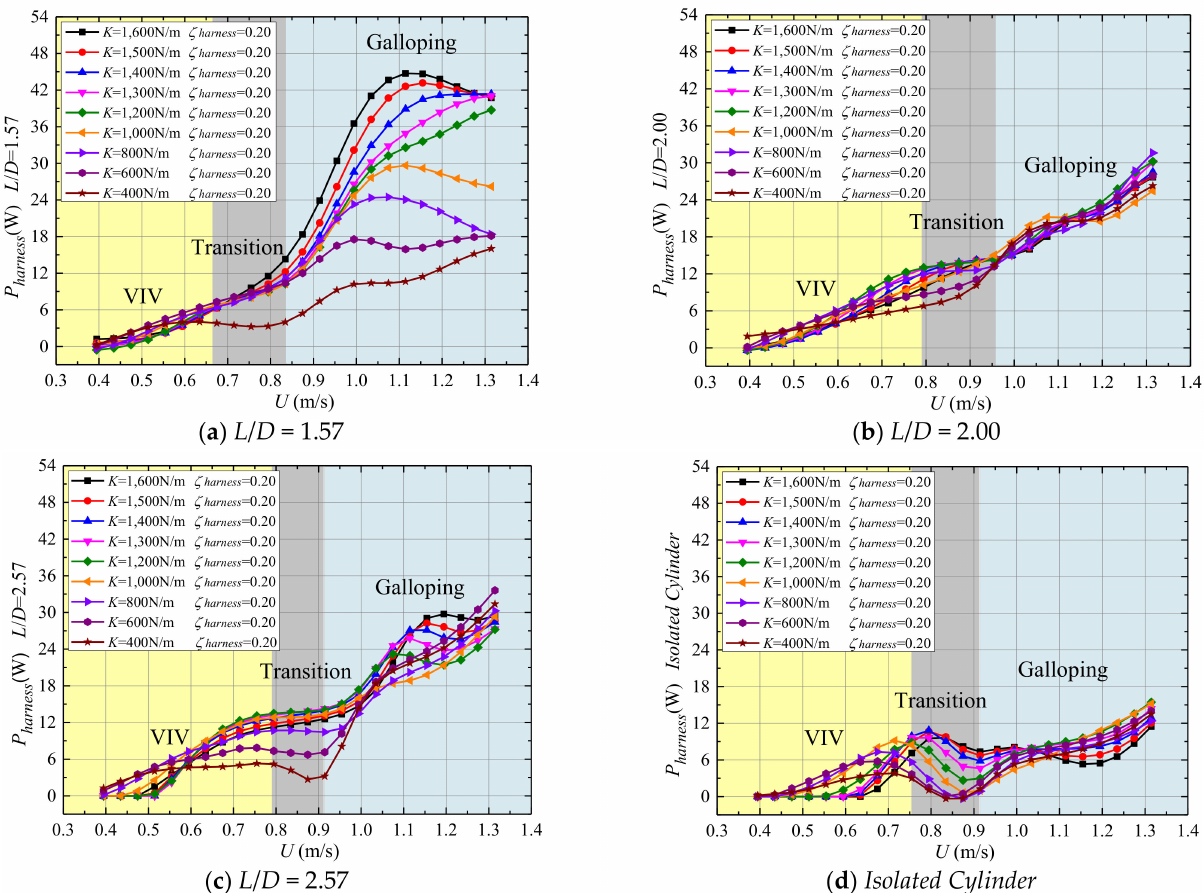
Figure 13. Harnessed power of two tandem cylinders with K = 400–1600 N/m and ζ harness = 0.20: ( a ) L / D = 1.57; ( b ) L / D = 2.00; ( c ) L / D = 2.57; ( d ) isolated